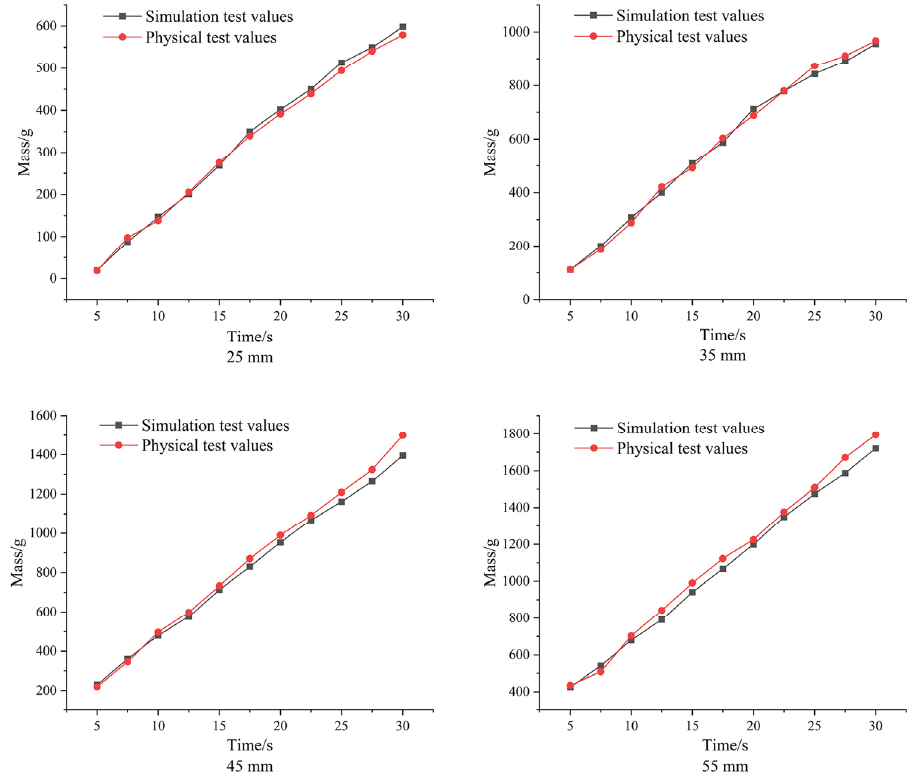
Figure 14. Comparison of results.